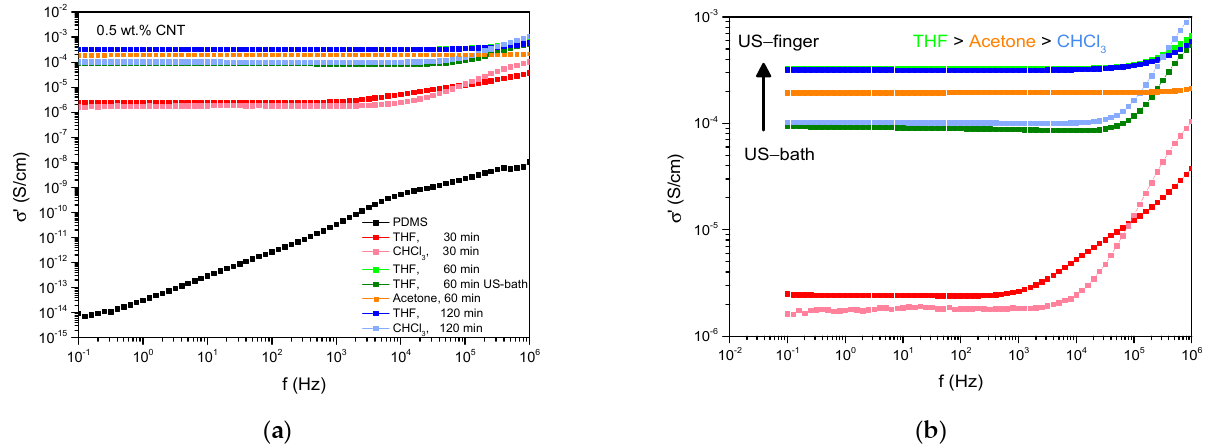
Figure 1. Dielectric results in dependency of ultrasonic terms ( a ) all results and ( b ) pre-dispersion results in detail.